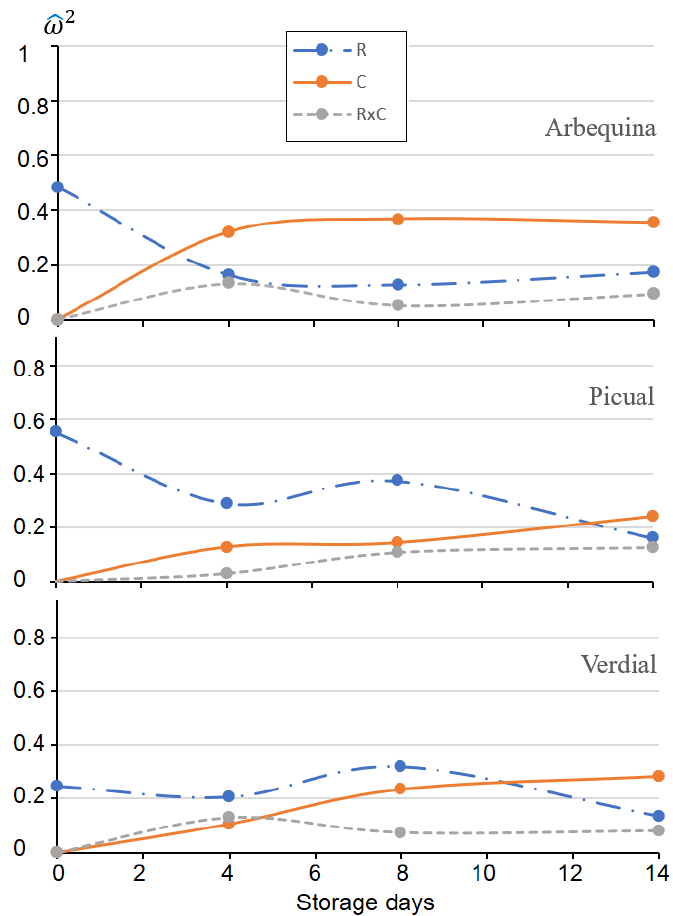
Figure 4. Magnitude of strength of the factors harvesting and conservation and their interaction for three different varieties (‘Arbequina’, ‘Picual’, and ‘Verdial’), based on the mean of the calculated omega-squared ( ˆ ω 2 ) values of 10 parameters (FFA, peroxides, K232, K270, oxidative stability, photosynthetic pigments, bitterness index, total polyphenols, and α -tocopherols) over 14 days. According to the official regulations, most of the samples analyzed did not receive the minimum number of negative evaluations necessary to lower their quality. Nevertheless, these negative evaluations can be considered to detail the applied treatments that were shown to be different, as was the case with the ‘Arbequina’ variety. This was achieved by calculating the median of the scores given by each of the tasters to the most negative attribute of a sample of a specific treatment. It is obvious that this calculation differs profoundly from the official one and that no normative maximum value can be given. However, it does permit us to compare the different treatments (Table 3). Calculating the median of the maximum grouped defects of each sample revealed that the deterioration became first visible in the treatments that were kept at room temperature. On day 14, fruit harvested with the traditional method (R2) and cold-stored (C1) presented the onset of deterioration. The oils from fruit picked with the MIU (R1) and kept at 5 ◦ C (C1) did not show a median above 0 during the time under investigation (Table